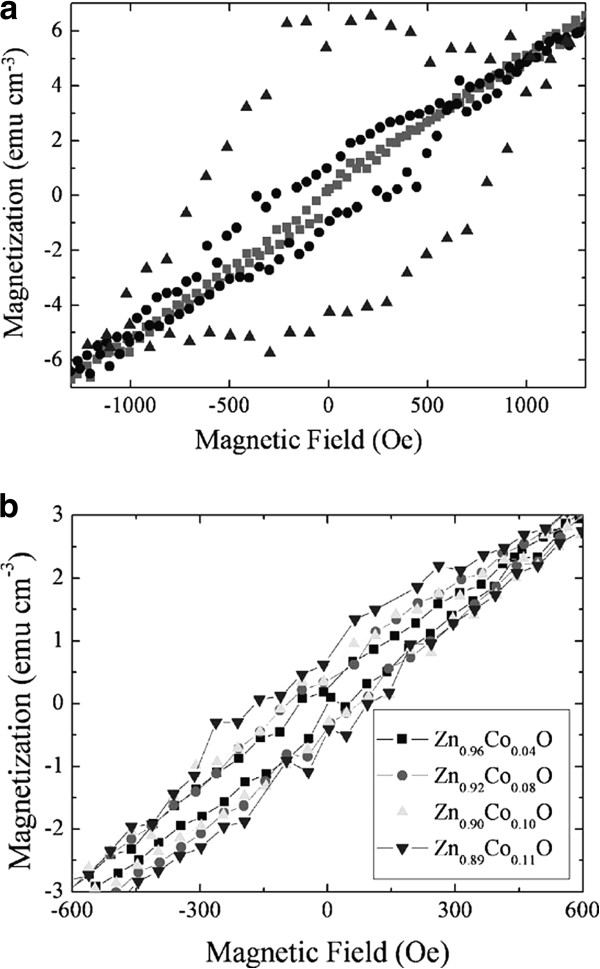
Magnetization as a function of applied field at 2 K for Zn0.89Co0.11O and Zn1-xCoxO NWs. (a) Magnetization as a function of applied field at 2 K for as-implanted (squares), argon-annealed (circles), and vacuum-annealed (triangles) Zn0.89Co0.11O NWs. (b) Magnetization as a function of applied field at 2 K for argon-annealed Zn1-xCoxO NWs. Reprinted with permission from Jian et al. [58].